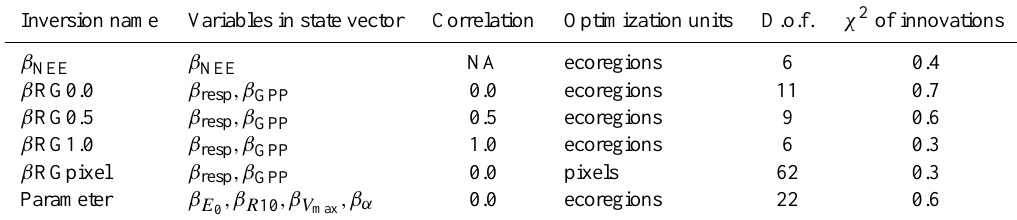
Table 1. Summary of the six inverse methods tested, indicating which variables are optimized in the inversions including their correlation and for which spatial unit they are optimized, the degrees of freedom (D.o.f.) as calculated from the a-priori covariance matrix of each system and the χ 2 of